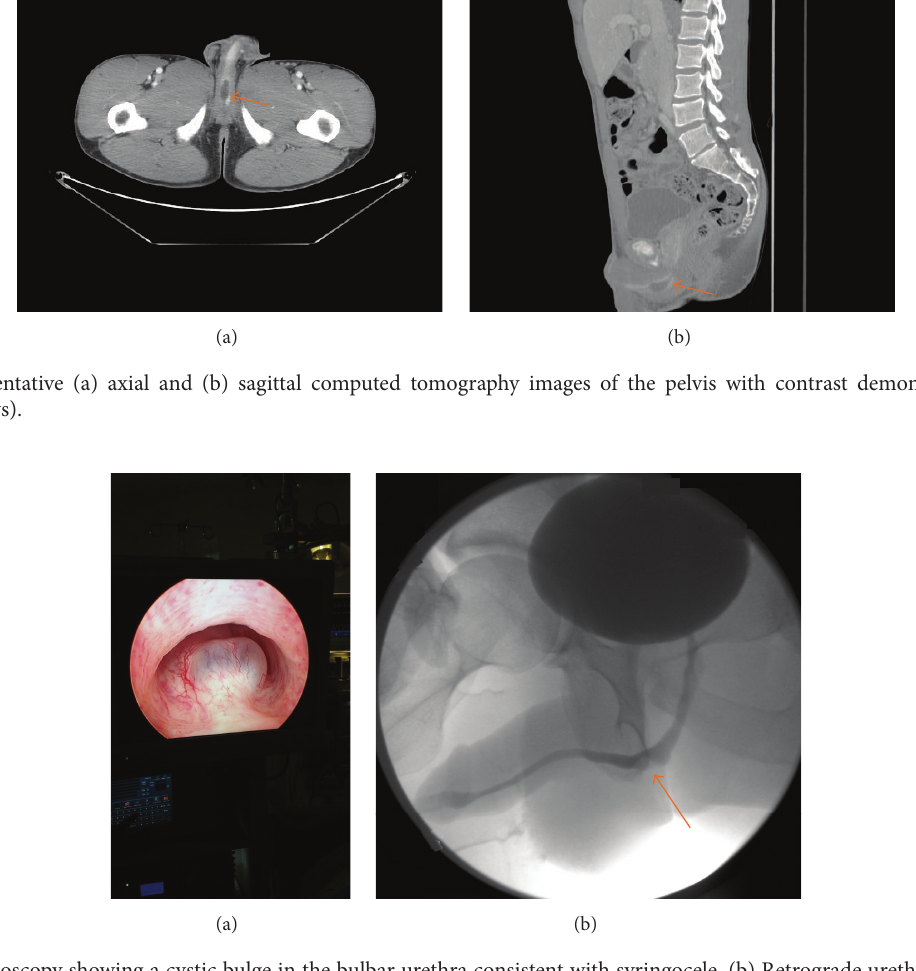
Figure 2: (a) Cystoscopy showing a cystic bulge in the bulbar urethra consistent with syringocele. (b) Retrograde urethrogram showing a filling defect in the bulbar urethra (arrow) consistent with